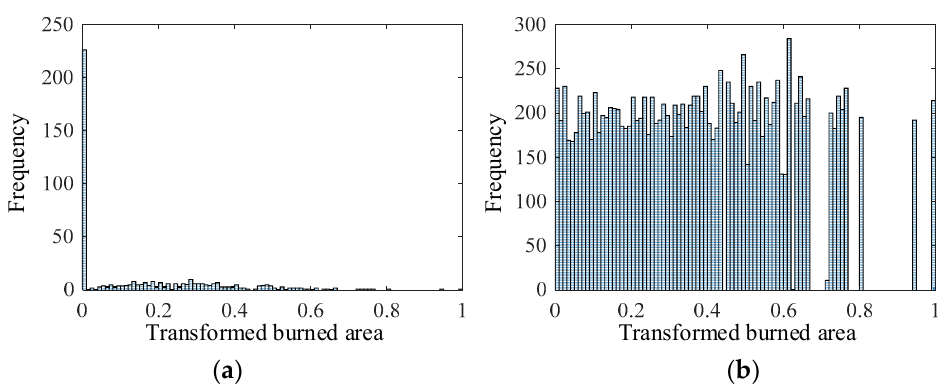
Figure 5. Histogram of targets of training set: ( a ) original; ( b ) after applying the data balancing procedure. A DNN with M = 3 hidden layers is constructed. Its encoder structure is K = 10, K 1 = 100, K 2 = 50, K 3 = 6, which is set following the general principle discussed in